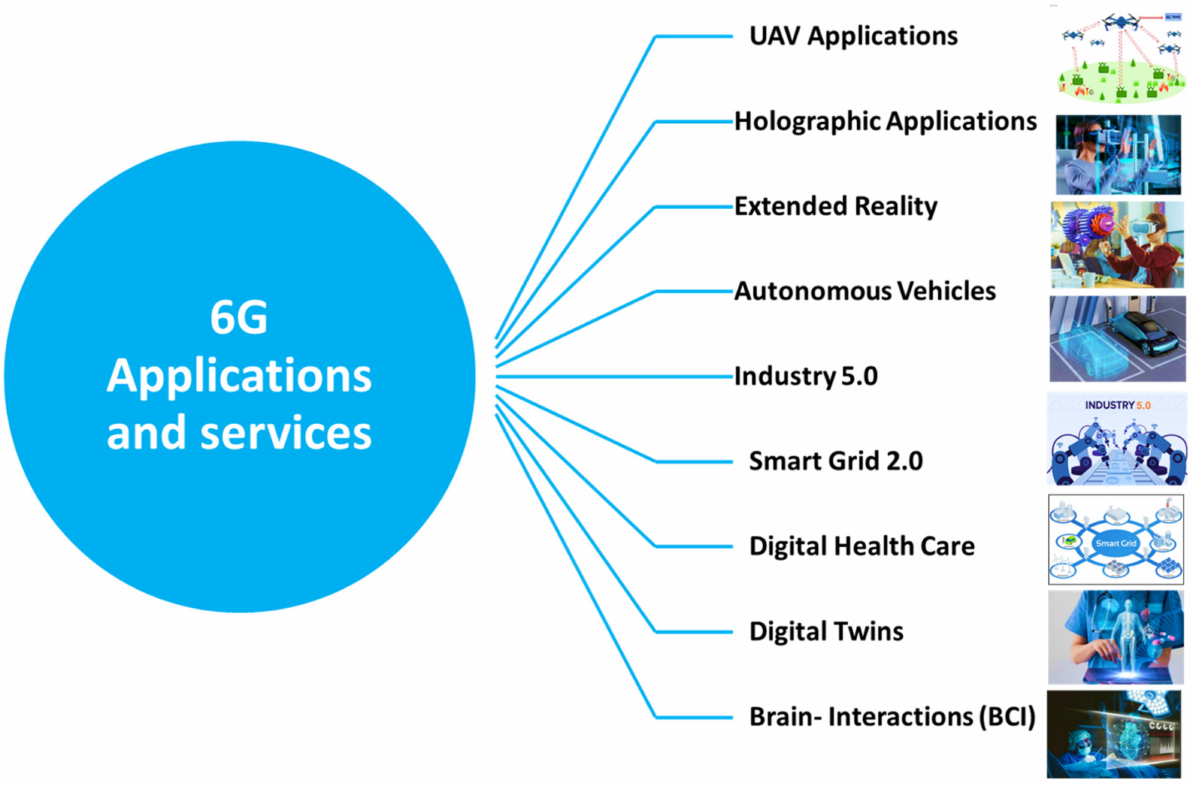
Figure 9. The most essential 6G applications in different